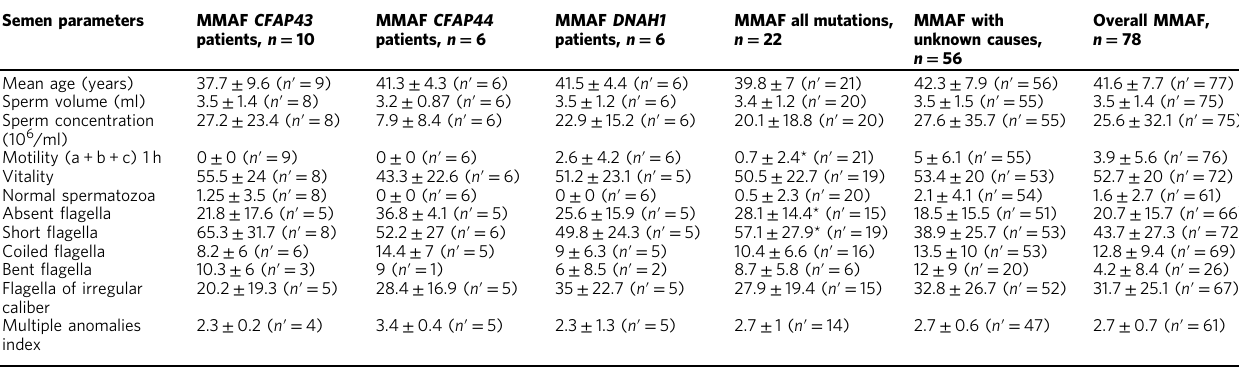
Table 1 Average semen parameters in the different genotype groups for the 78 MMAF subjects Semen parameters